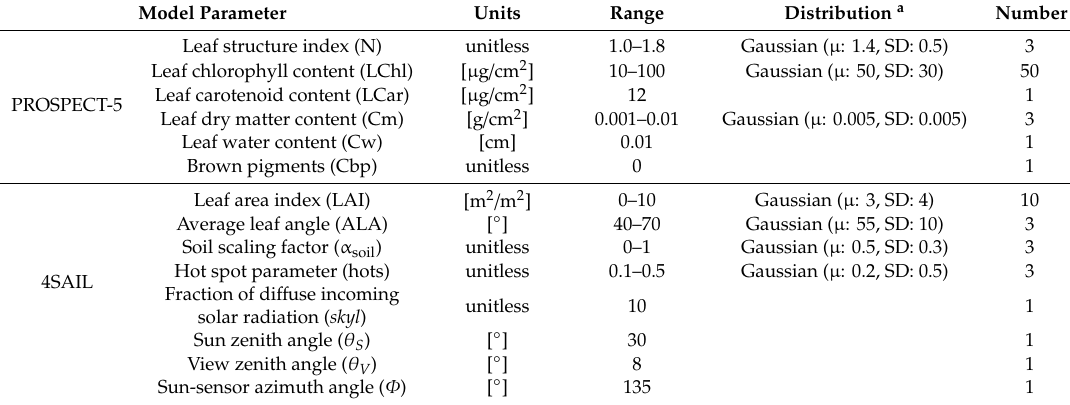
Table 2. Statistics of the input variables of the PROSPECT-5 and 4SAIL models used to generate the training